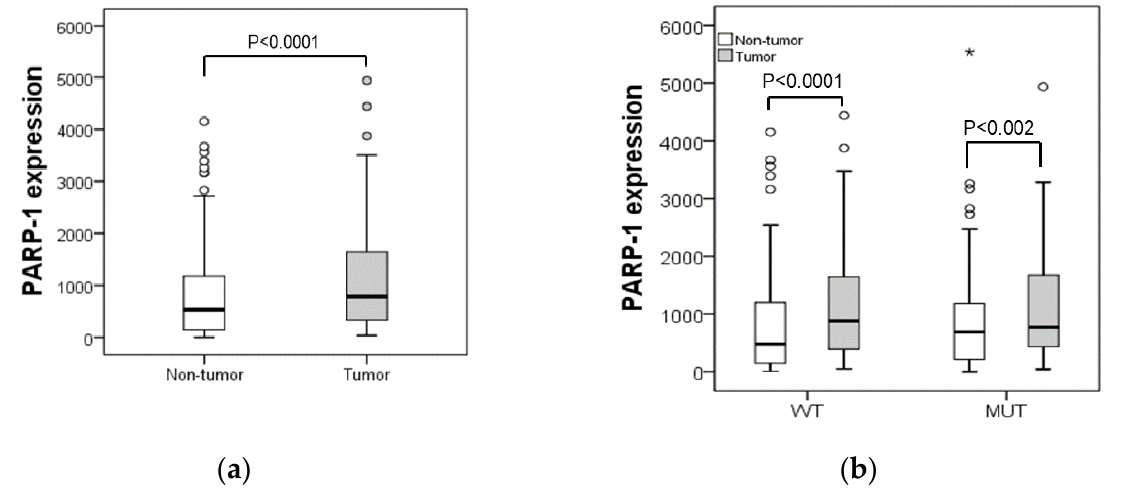
Figure 1. Box-plots representing PARP-1 expression in tumour and non-tumoral samples ( a ) from all patients and ( b ) patients stratified by p53 status in wild-type (WT) and mutated (MUT). Comparations were made by using non-parametric tests in two related samples. ° Represent outliers beyond 1.5 times the interquartile range (ICR); * Represent outliers beyond 3 times the ICR. Table 1. Relationship between PARP-1 expression and clinicopathological characteristics of patients at different status of p53